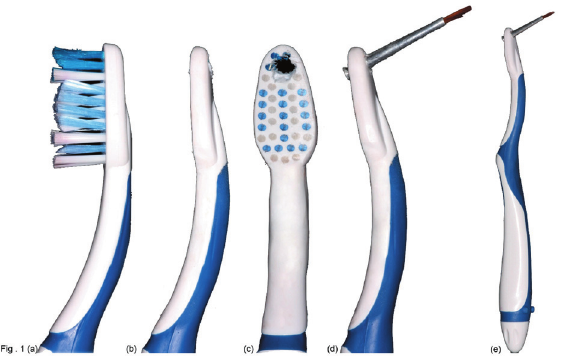
Figure 1- Step-by-step fabrication of the portable